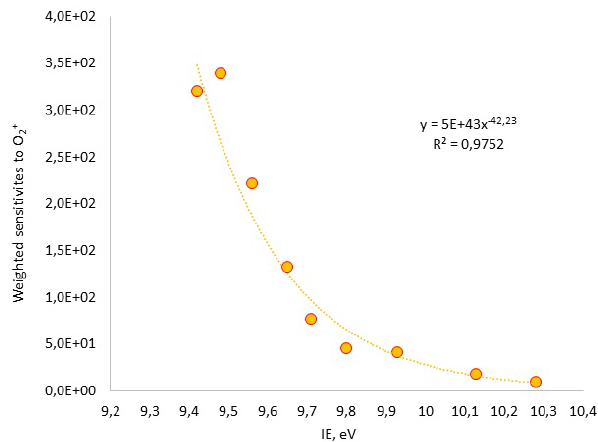
Figure 6. Ionization energy vs. sensitivities weighted to O + alkanes reacting via charge transfer.